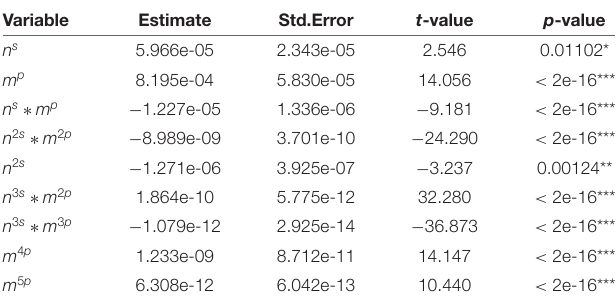
TABLE 6 | Summary statistics for selected variables in finite sample size between 121 and 200.